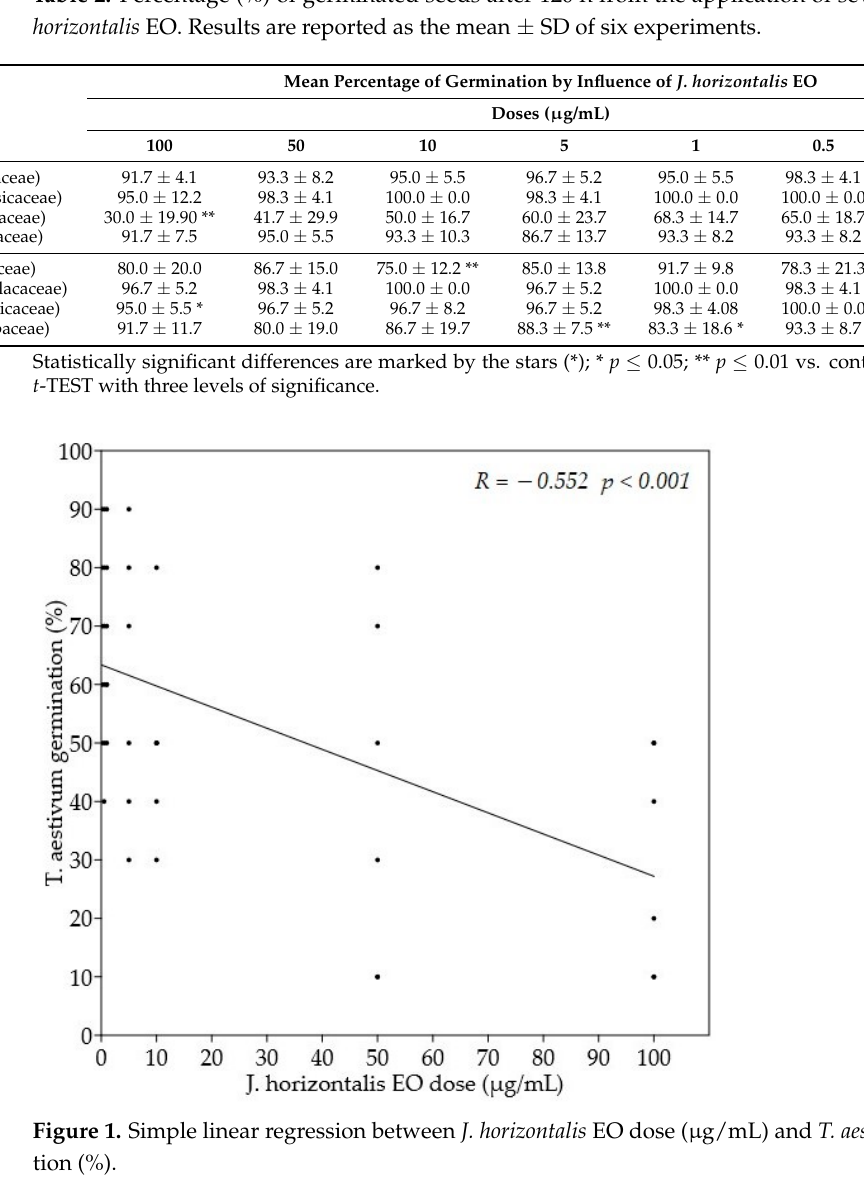
Figure 2. Bar-chart showing differences between Lolium perenne (L.p.) and Barbarea vulgaris (B.v.) percentages of germinated seeds in comparison to control (con.) after application of 10 µg/mL and 100 µg/mL of Juniperus horizontalis essential oil.